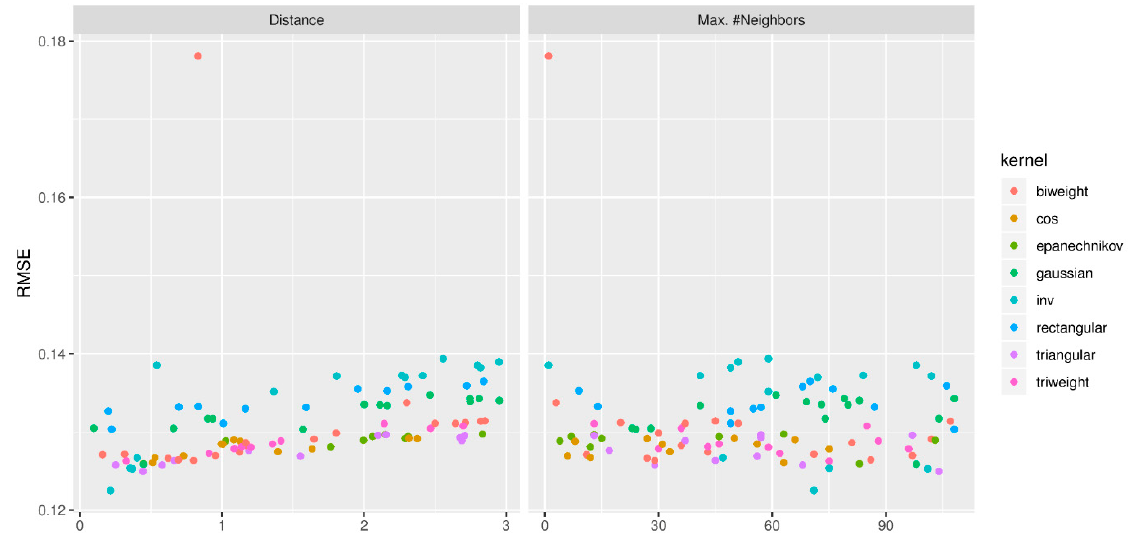
Figure 10. Performance of the cubist model in predicting ilmenite content.